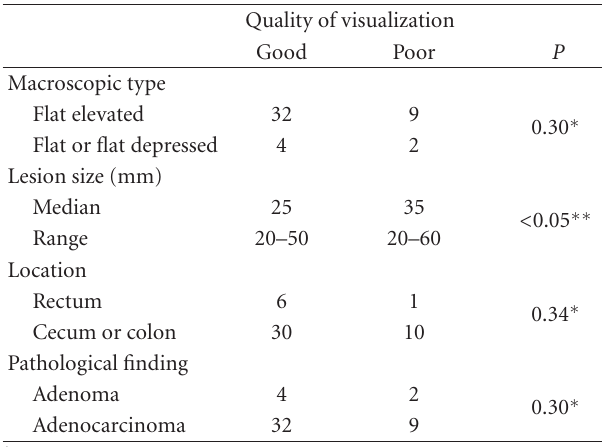
Figure 4: LST-NG lesions categorized as “wellvisualized” by using AFI. Location: lower rectum. Size of the lesion: 45mm. Macroscopic type: IIa (LST-NG). Pathological findings: well and moderately di ff erentiated adenocarcinoma, pSM (350um). Table 2: Backgrounds of the LST-NG lesion evaluated by AFI in group